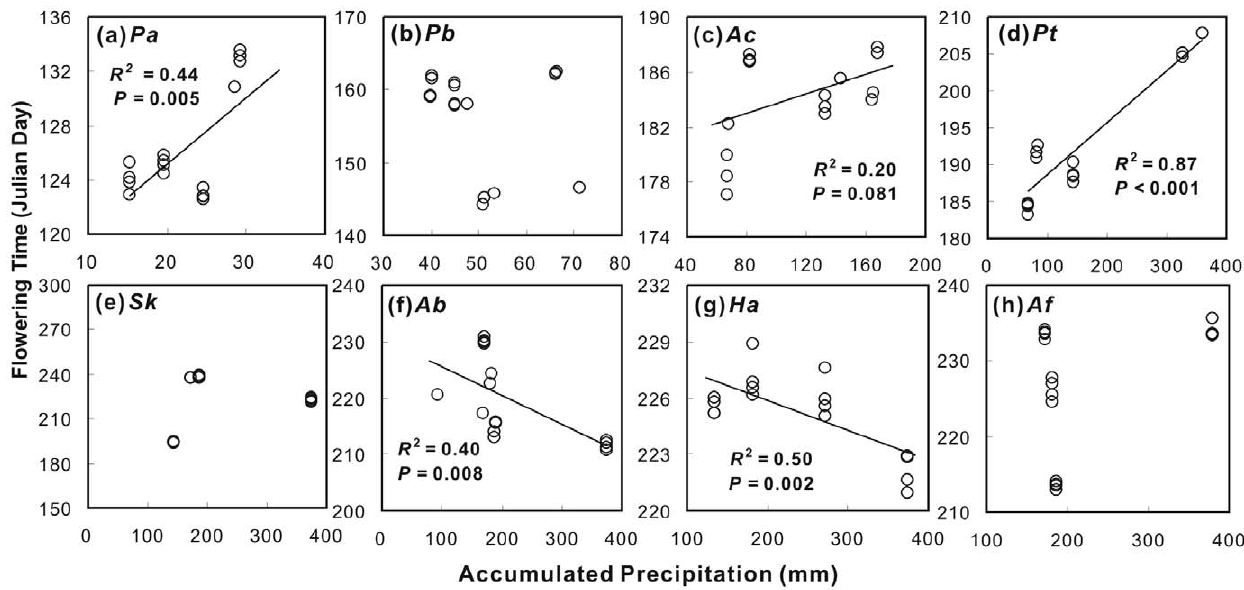
Figure 6. Relationships between the flowering time and accumulated precipitation in preceding periods (from Jan. 1) for the 8 species. See Fig. 2 for species name abbreviations.